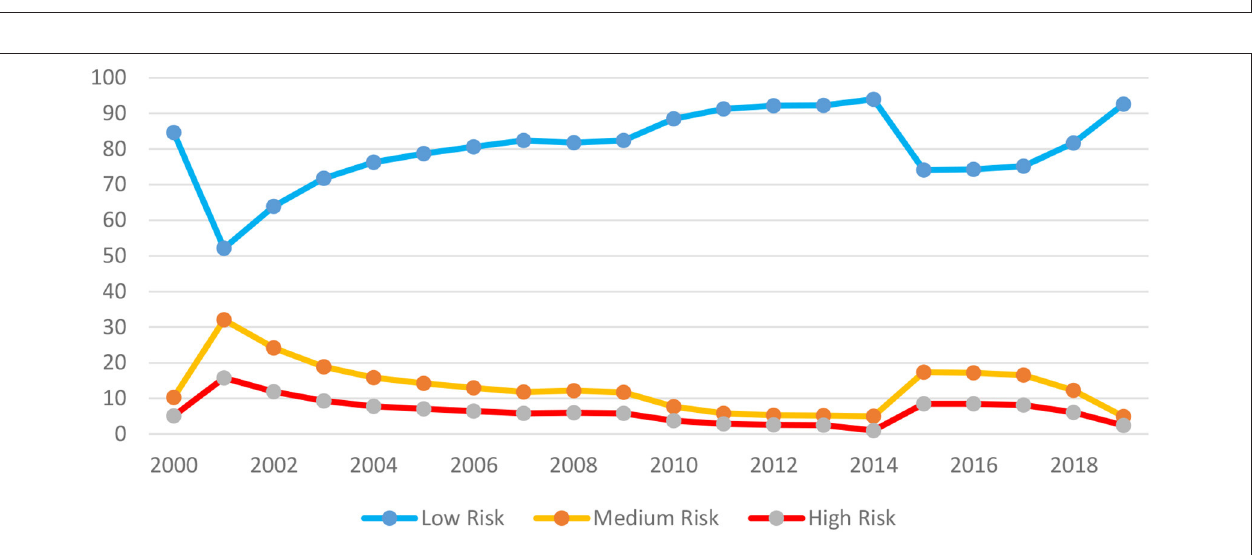
FIGURE 5 | Oil &gas investment environment risk in Brazil from 2000 to 2019.